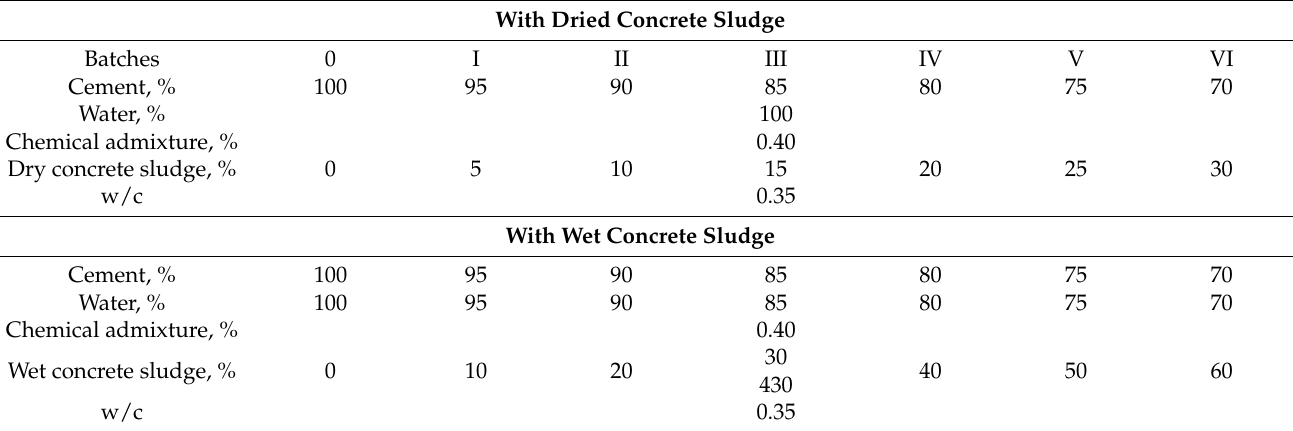
Table 3. Mixing proportion of hardened cement paste.